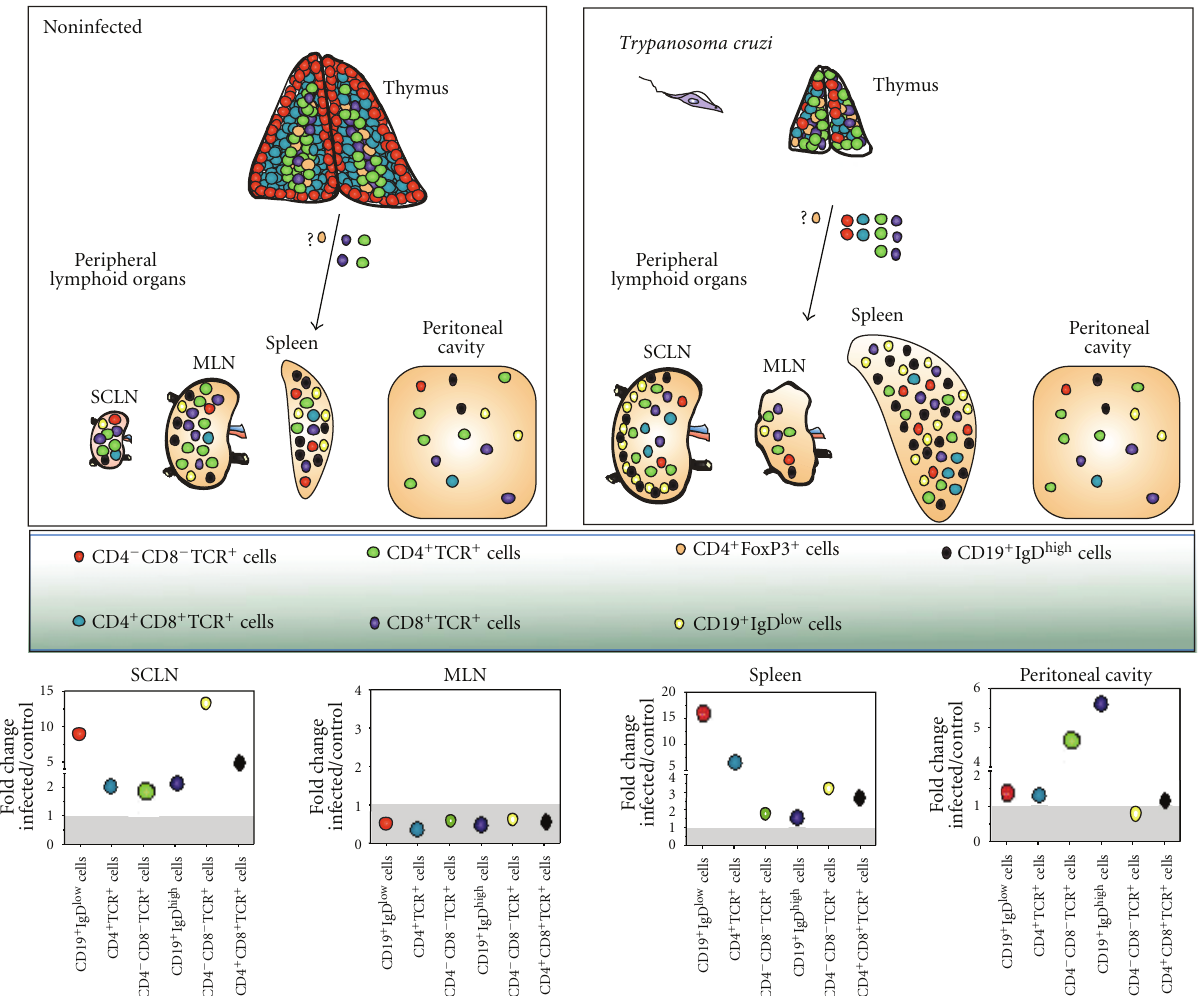
Figure 2: Distinct pattern of lymphocyte fluctuations in central and peripheral lymphoid organs during acute Trypanosoma cruzi infection . The upper panels depict thymus and peripheral lymphoid sites, in terms of T- and B-cell subsets. It is illustrated the thymic atrophy, simultaneously with an increase in mature and immature export of cells from the organ, as well as hyperplasia of spleen and subcutaneous lymph nodes that course in parallel with an atrophy of the mesenteric lymph nodes, whereas the peritoneal cavity remains rather unchanged (except for the significant rise in CD4 + and CD8 + T-cell subsets). Bottom panels reveal fold changes of each T- and B-lymphocyte subsets from acutely infected mice over the corresponding